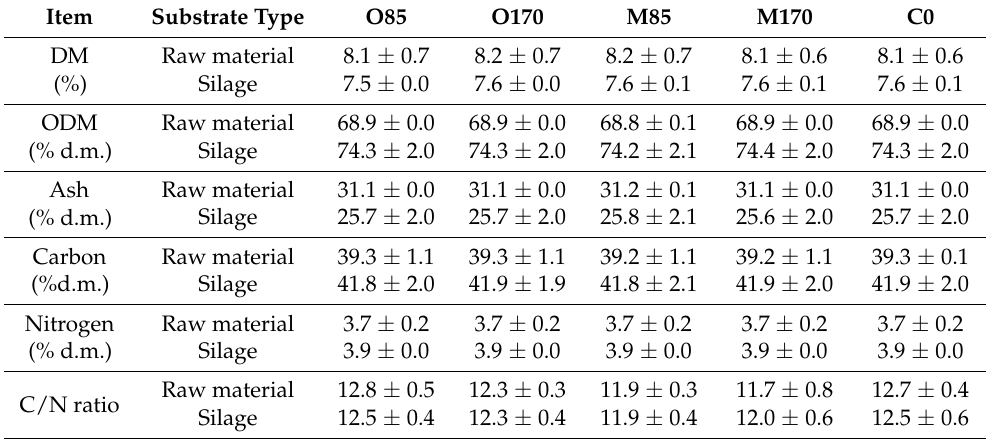
Table 6. Characteristics of the mixture of anaerobic sludge and substrate raw material/silage of Silphium perfoliatum used for the anaerobic digestion